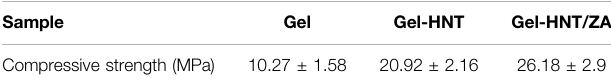
TABLE 2 | Compressive strength of the